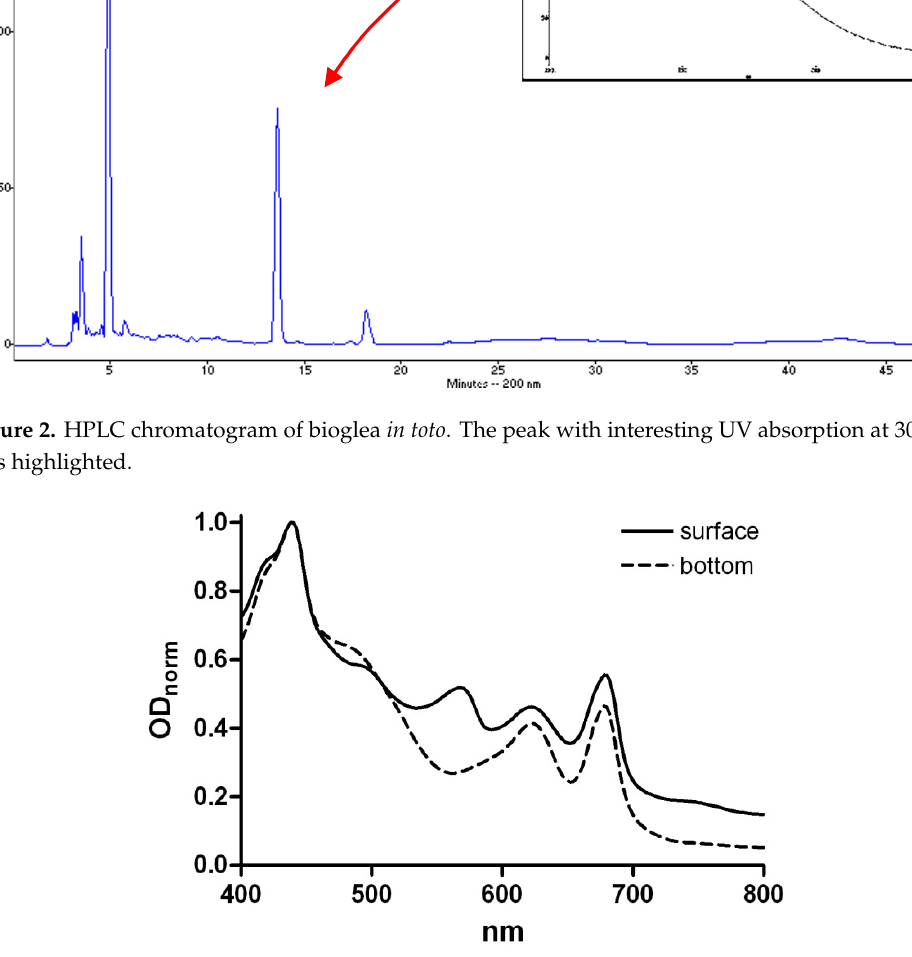
Figure 3. Absoption UV spectra of hydrophilic extracts of surface and bottom bioglea.